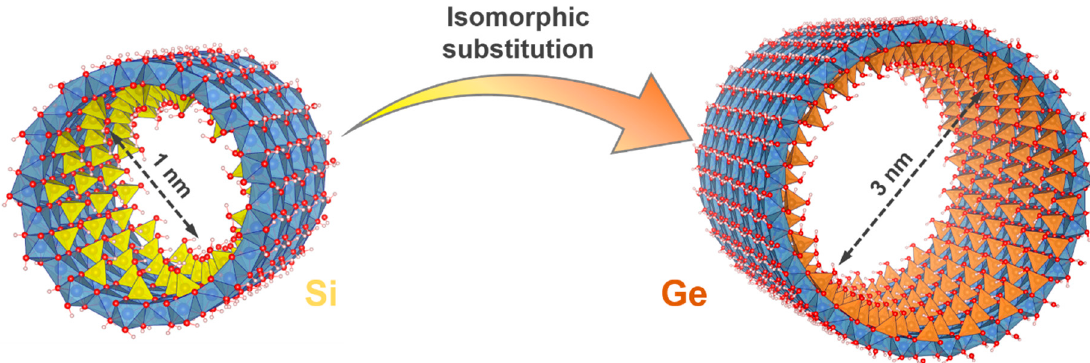
Figure 13. Structure and inner diameter size for the endmembers of single-walled imogolite clay nanotubes (INT) with nominal composition (OH) 3 Al 2 O 3 Si x Ge 1–x (OH). Color code: silicon (yellow); germanium (orange); aluminum (blue); oxygen (red); hydrogen (white).